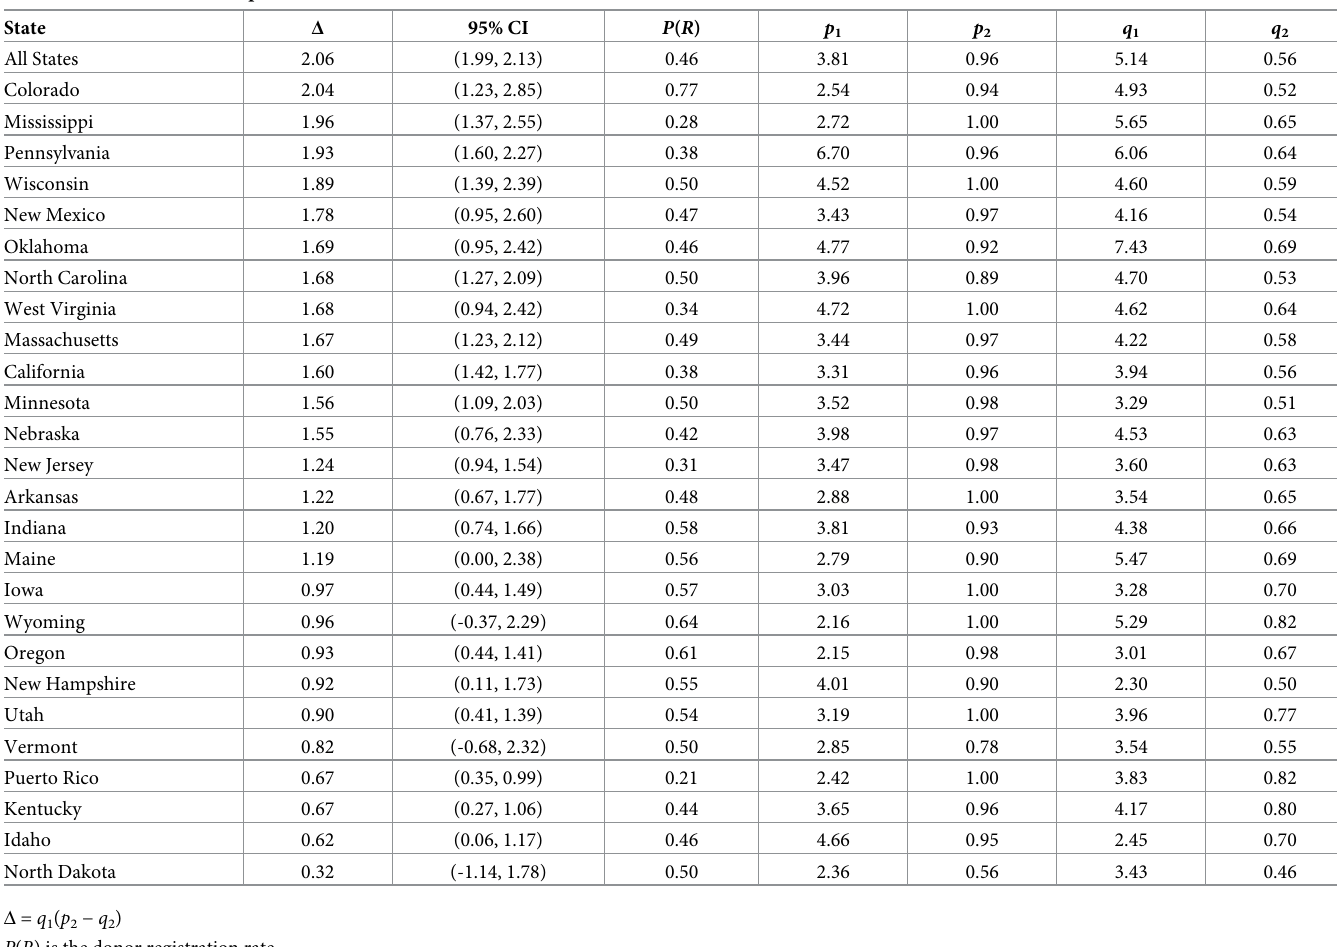
Table 2. 2018 state estimates, part